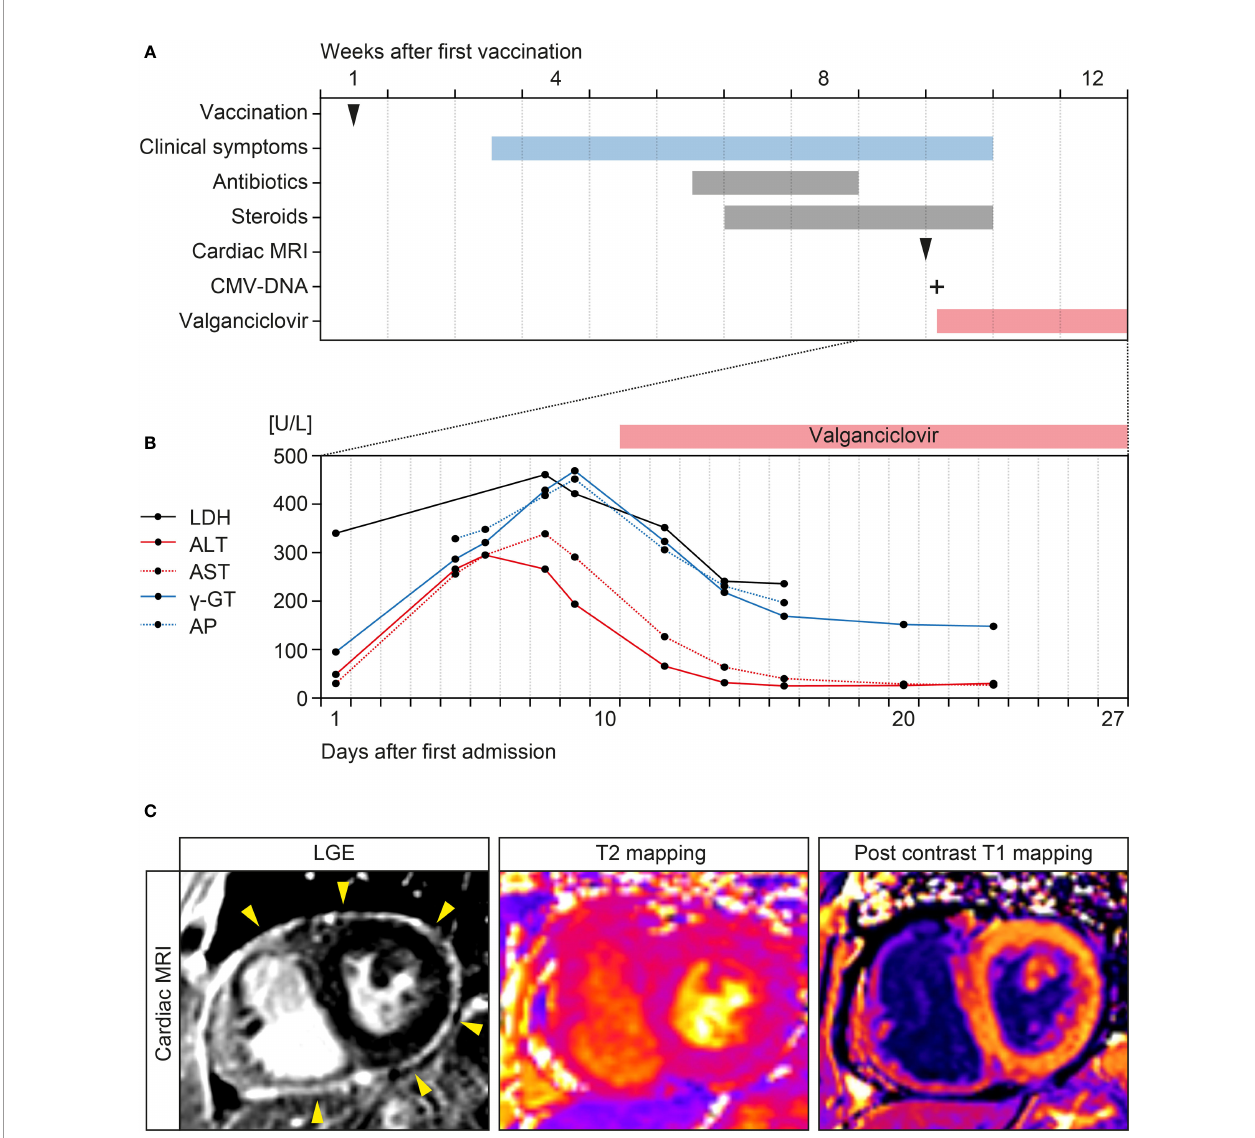
FIGURE 1 | Timeline of the case and cardiac MRI fi ndings. (A) Time of ChAdOx1 nCoV-19 vaccination, onset of clinical symptoms, and treatment regimens. (B) Time course of laboratory parameters including LDH, AST, ALT, g -GT, and AP after admission. (C) LGE con fi rming circumferential thickening and contrast enhancement of the entire pericardium (yellow arrowheads) without presenting myocardial enhancement. Advanced tissue characterization with T2 mapping and post contrast T1 mapping did not show evidence of myocardial edema or myocardial enhancement, con fi rming the diagnosis of isolated pericarditis. ALT, alanine aminotransferase; AP, alkaline phosphatase; AST, aspartate aminotransferase; CMV, cytomegalovirus; g -GT, g -glutamyl transferase; LGE, late gadolinium enhancement; MRI, magnetic resonance